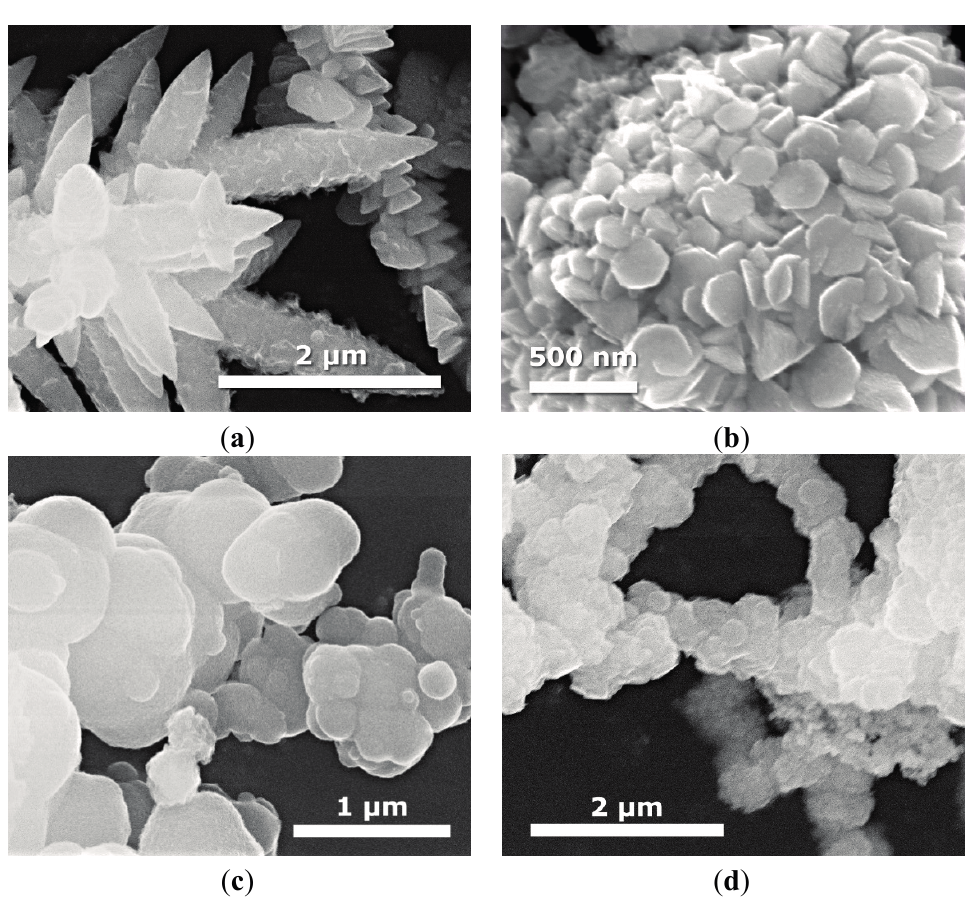
Figure 3. SEM images of binary CdS-MoS 2 composites obtained by solvothermal mixed solution methods with different molar ratio of CdS: ( a ) CdS:MoS 2 = 5:1; (sample CdS-MoS 2 5-1); ( b ) CdS:MoS 2 = 4:1 (sample CdS-MoS 2 4-1); ( c ) CdS:MoS 2 =